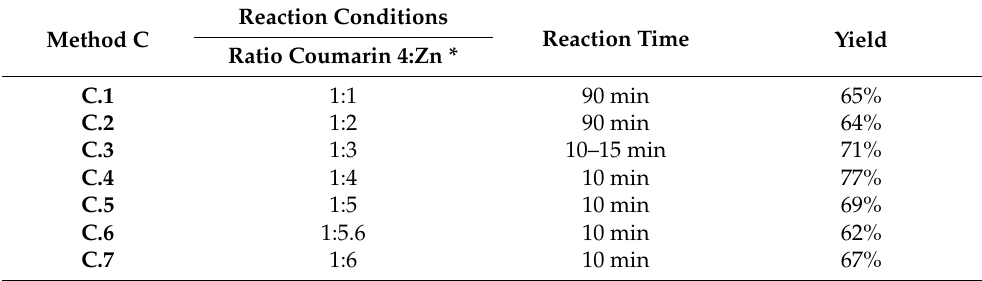
Table 5. Optimization of the applied amount of metallic Zn.